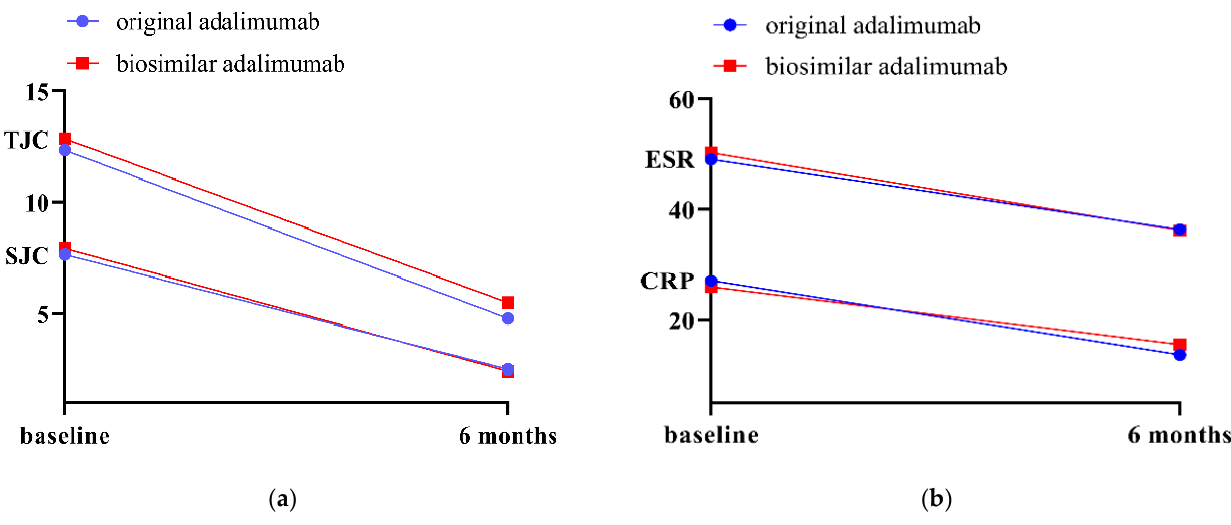
Figure 2. Grouped mean values of joint counts ( a ) and of inflammatory markers (( b ); CRP in mg/L, ESR in mm/h, normalized by outlier exclusion for illustration purposes) at baseline and 6 months in patients starting either original ( n = 213; blue circle) or biosimilar adalimumab ( n = 228; red square). Table 3. Number of reported AEs in RA patients while on